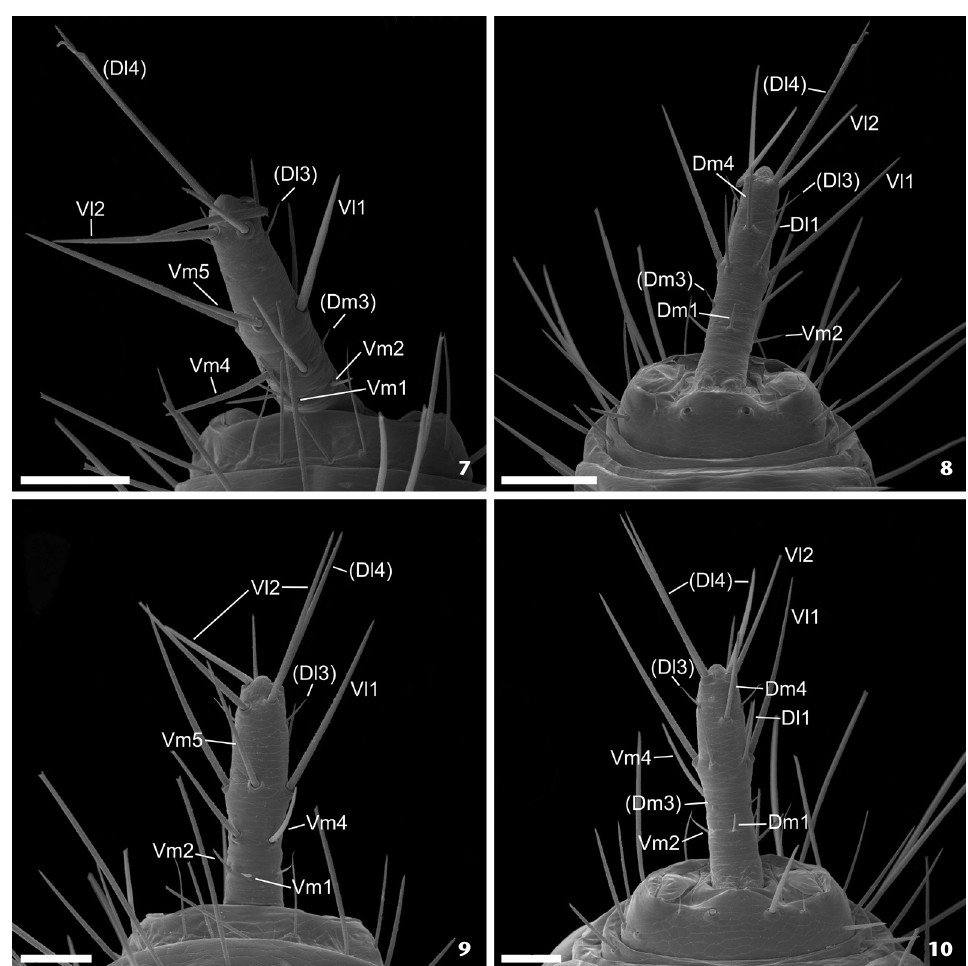
Figures 7-10. Female flagellum. Naderiore carajas gen. nov. , sp. nov. : (7) ventral; (8) dorsal. Cangazomus xikrin gen. nov. , sp. nov. : (9) dorsal; (10) ventral. Scale bar: 0.05 mm. Note: The setae named in parentheses correspond to the nomenclature of the flagellar setation proposed by V illarreal et al. (2014) and M oreno -G onzález et al. from a central pore. Spermathecae (Fig. 17) consist of two pairs of almost straight lobes, with their apex anteriorly directed, whose distal circular bulbs are slightly marked and roughly so thick as the stalk; median lobes slightly thinner and shorter than lateral ones, both with cylindrical stalks covered with numerous DO over surface. Chitinized arch incomplete, AB and PB open, LT sharp and short with an anterior notch, IA rounded, without AMN and AMP.